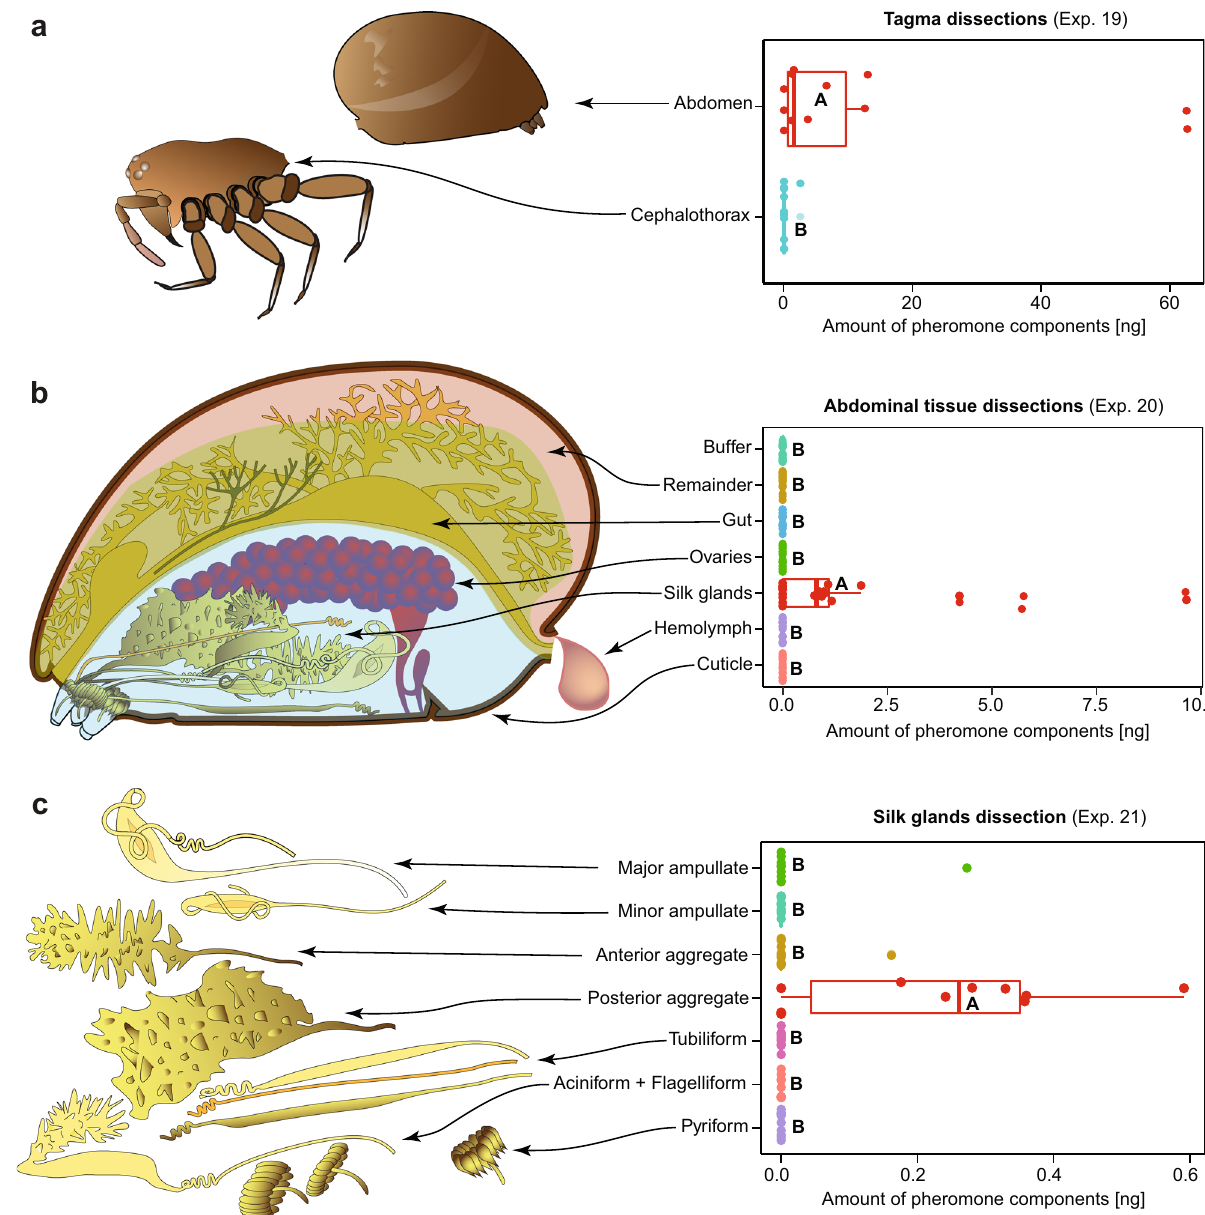
Fig. 3 Origin of contact pheromone components produced by female Steatoda grossa . a High-performance liquid chromatography – mass spectrometry (HPLC-MS) quanti fi cation of two contact pheromone components [ N -4-methylvaleroyl- O -isobutyroyl- L -serine ( 12 ) coeluting with N -4-methylvaleroyl- O - isobutyroyl- L -serine ( 16 )], present in the abdomen and cephalothorax of female spiders. b HPLC-MS quanti fi cation of 12 and 16 in the haemolymph and various tissues of the abdomen. c HPLC-MS quanti fi cation of 12 and 16 in various silk glands. In each of experiments 19 – 21, circles and boxplots show the amount of 12 and 16 present in each spider and the distribution of data (minimum, fi rst quartile, median, third quartile, maximum), respectively. Medians with different letters indicate signi fi cantly different amounts of 12 and 16 present in various sources; Wilcoxon and Kruskal – Wallis χ 2 test with Benjamini – Hochberg correction to account for multiple comparisons, P <